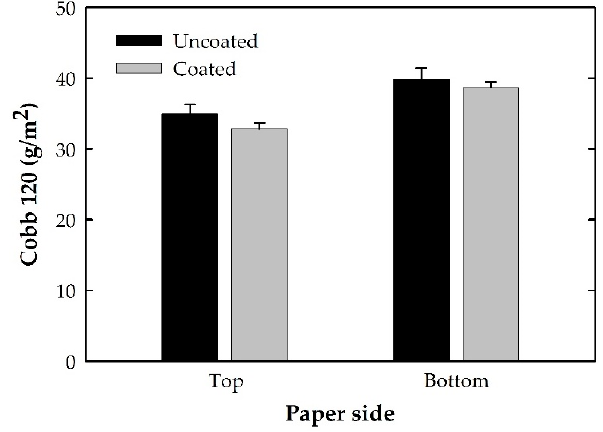
Figure 4. Water absorptiveness values for the uncoated and coated paper as obtained from the Cobb’s test.